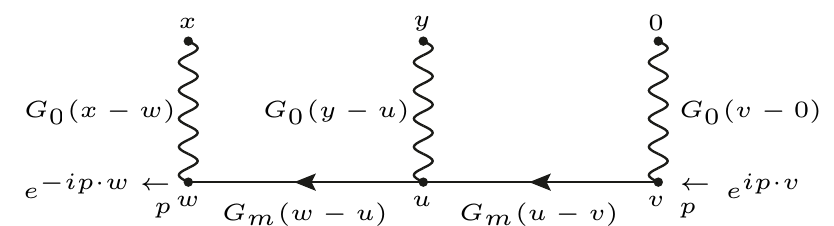
Figure 3 . Feynman diagram of the QED part of the HLbL contribution in the muon g − 2 in position space, see figure 2, corresponding to the scalar function I ( p, x, y ) IR reg . in eq. (2.11). Note that the arrows on the muon line are only meant for illustration; all propagators are scalar functions. In the derivation, the Euclidean momentum p flowing through the diagram was assumed to be